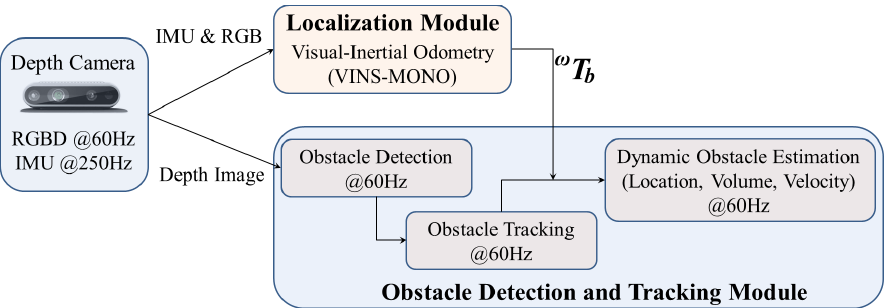
Figure 2. Block diagram of the proposed system for robust dynamic obstacle detection and tracking using RGB-D camera sensor